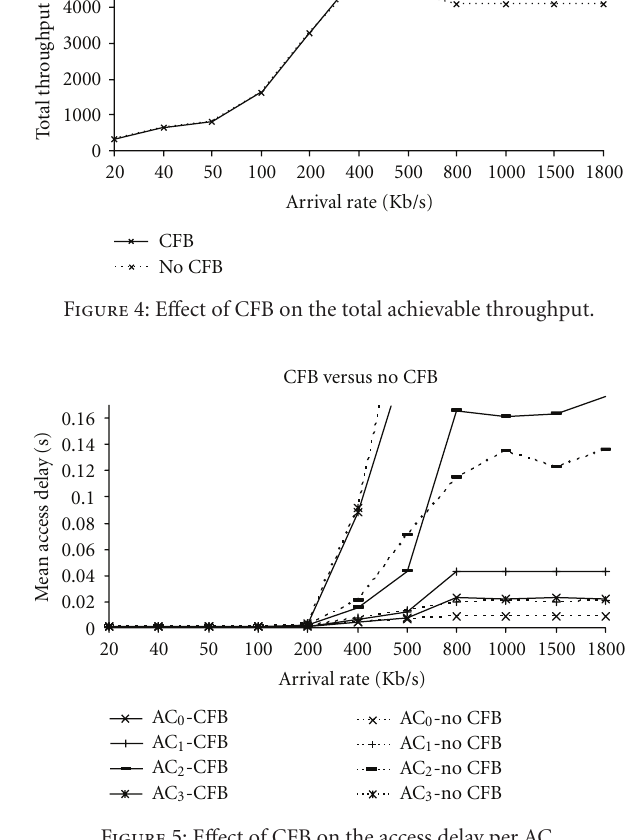
mode, basic mode or RTS/CTS mode, the transmission time for a single data frame may vary. This time is named T s 1 . It is given in (1) and (2) and schematized in Figures 6(a) and 6(b). Collision time T c is also illustrated in Figures 6(c) and 6(d) and given in (1) and (2); it will be used later in the analytical